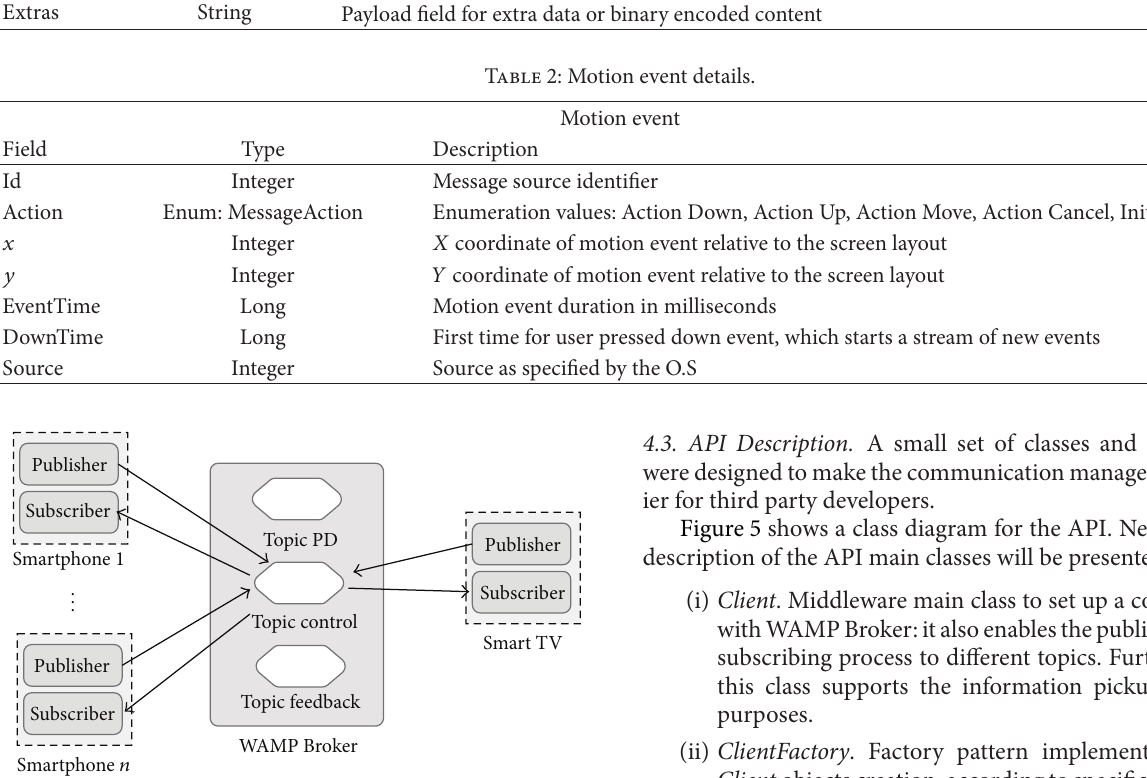
Figure 4: Control information